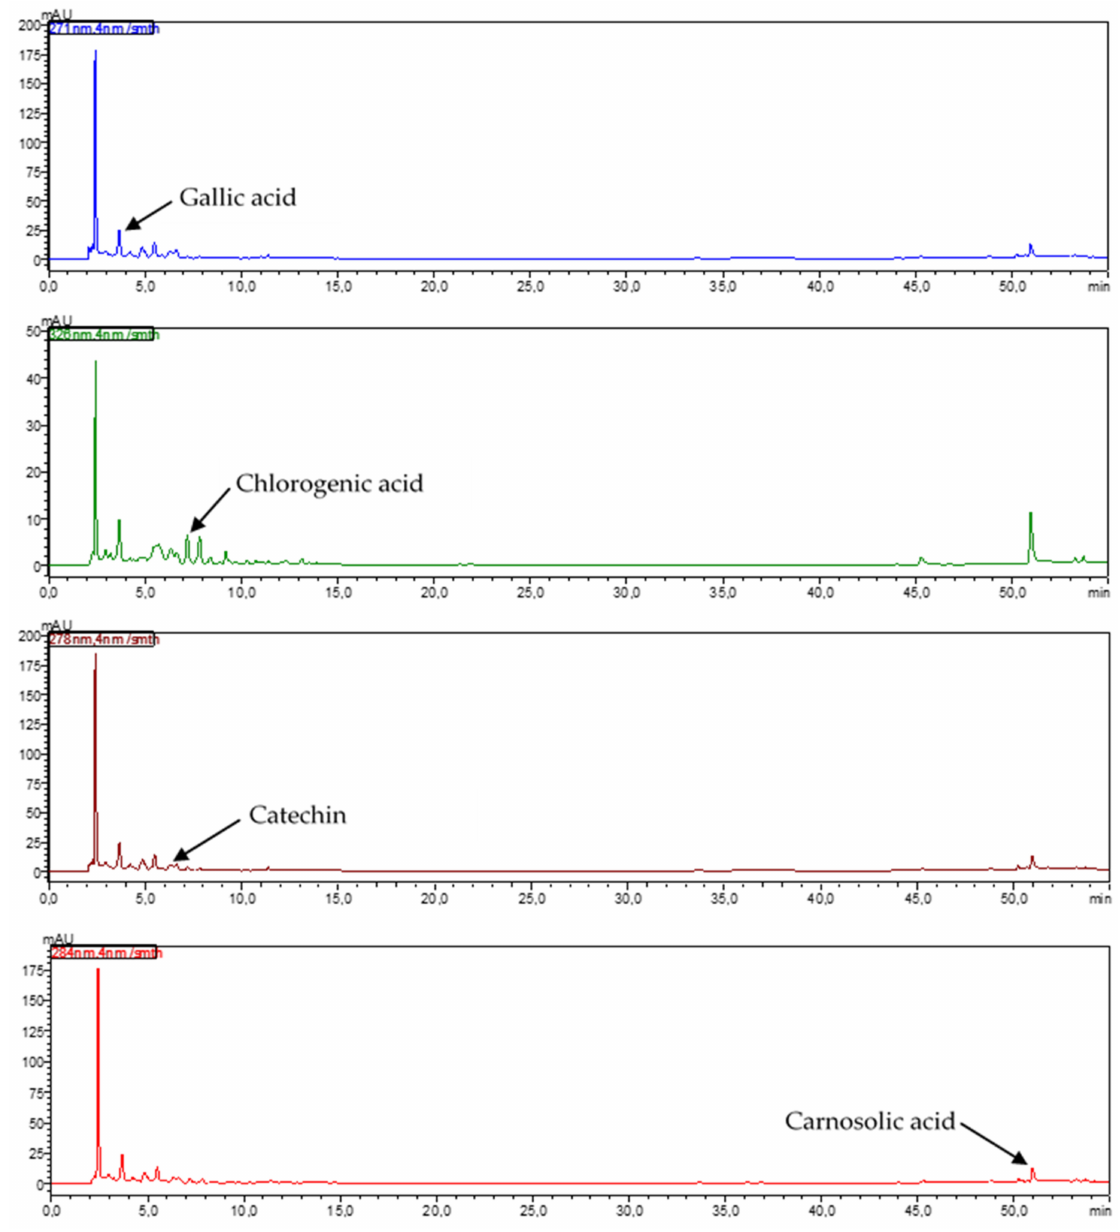
Figure 2. HPLC-DAD chromatograms of selected polyphenols identified in the juice from the root of beetroot at full